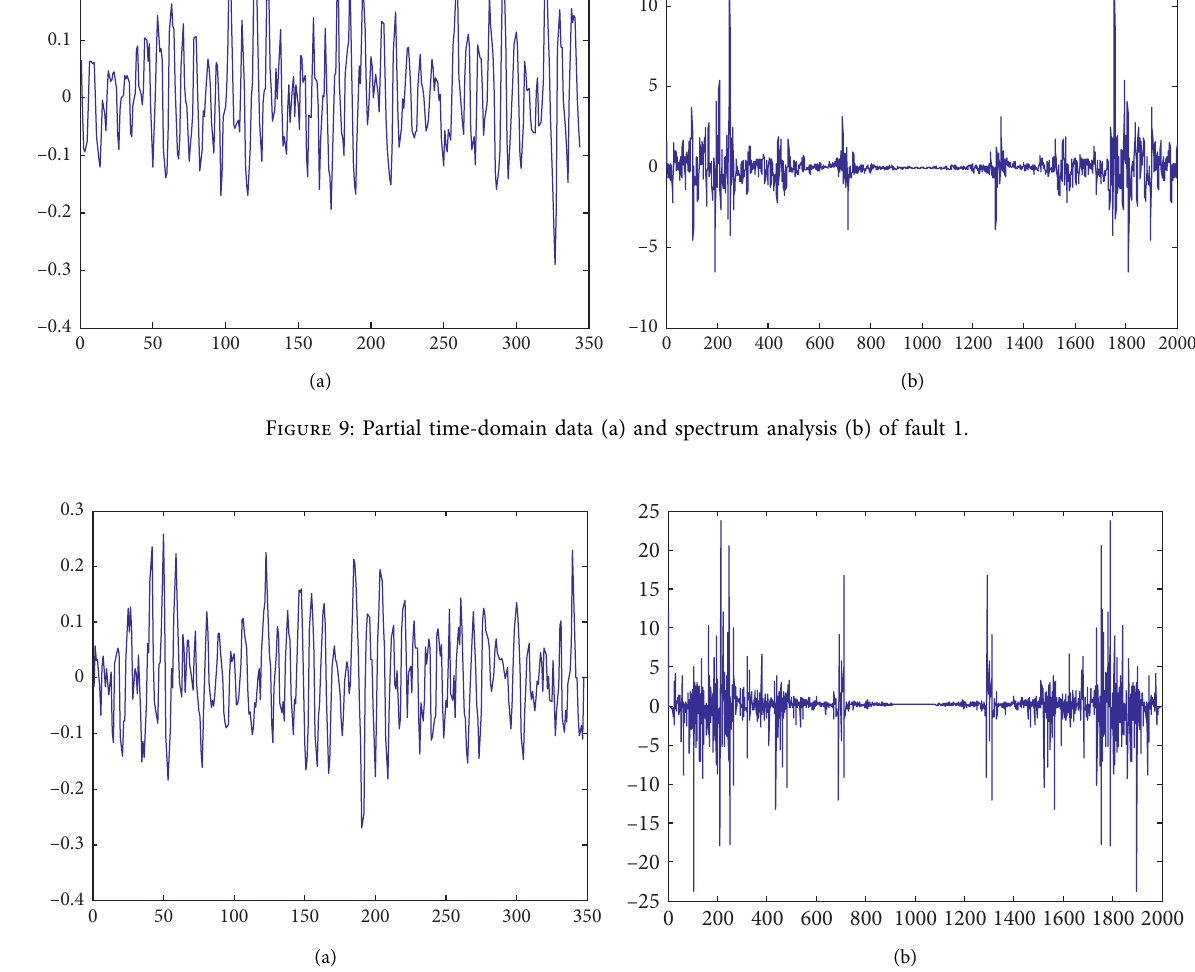
Figure 10: Partial time-domain data (a) and spectrum analysis (b) of fault 2.